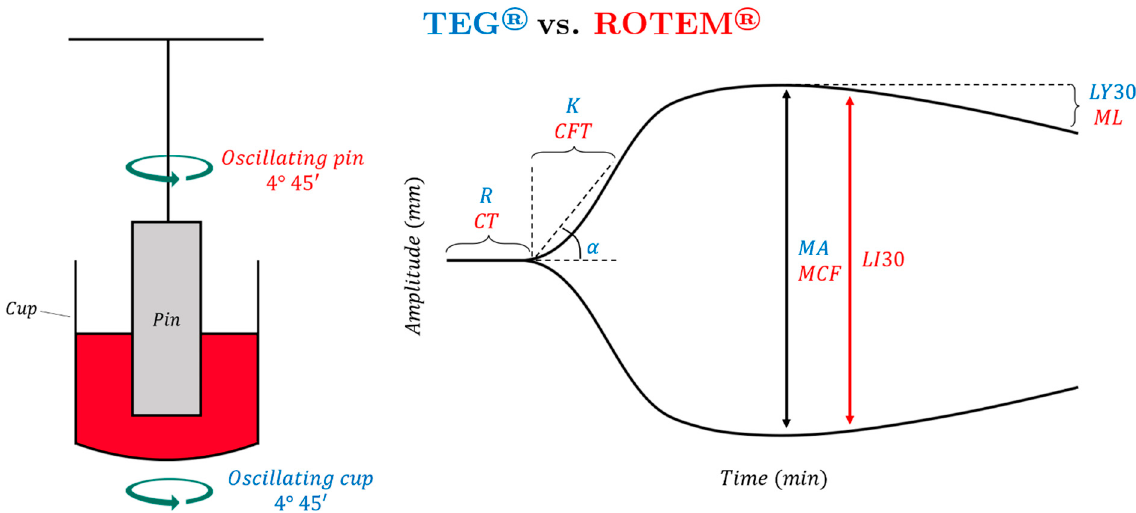
Figure 1. A 0.36 mL citrated sample of whole blood is placed into a heated cup maintained at 37 ◦ C in which a pin is suspended. In TEG, the cup oscillates while the pin is stationary; in ROTEM, the pin oscillates while the cup remains stationary. In both assays, citrate anticoagulation is reversed with calcium, and a coagulation activation reagent is added; as the blood coagulates, force is detected by the pin and transmitted to an electrical transducer, producing a graphical output that represents clot dynamics over time. Reaction time (R) and clotting time (CT) represent the amount of time until the tracing reaches 2 mm in amplitude. Kinetics (K) and clot formation time (CFT) represent the amount of time between 2 mm of amplitude and when the tracing reaches 20 mm in amplitude. The α -angle is used in both TEG and ROTEM; it represents the angle between the horizontal line and the line between clot initiation and 20 mm amplitude. Maximum amplitude (MA) and maximum clot firmness (MCF) represent the maximum amplitude that the tracing reaches. Lysis at 30 min (LY30) represents the percentage decrease in amplitude 30 min after reaching MA. Clot lysis index (CLI30) represents the percentage of amplitude remaining 30 min after reaching MA. Maximum lysis (ML) refers to the percentage decrease in amplitude relative to the MCF at the end of the run.